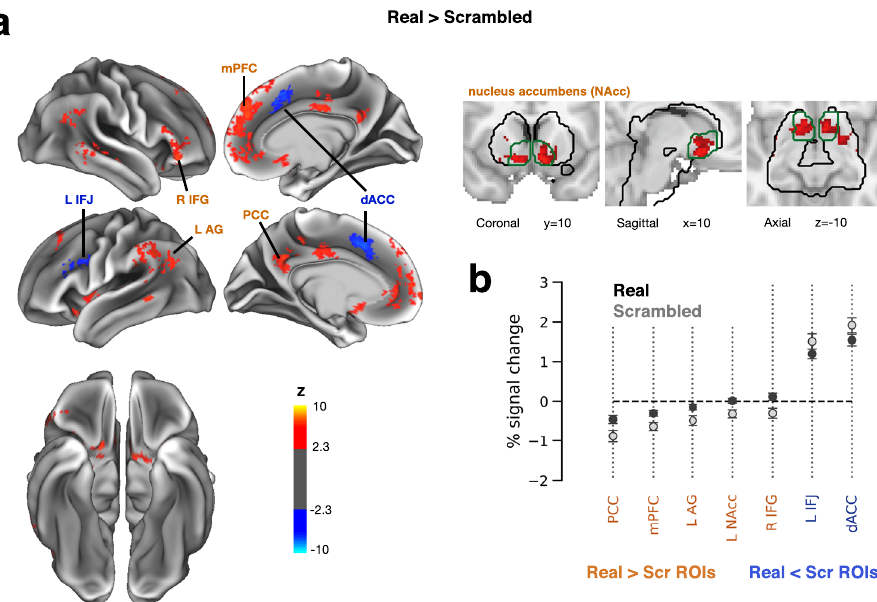
Fig. 6 Comparing the neural responses to phase-scrambled and real object images. a Group-level GLM contrast of real object > scrambled images. Left: data overlaid on a template cortical surface. Right: data presented in subcortical regions only (within black contour; green contour indicates nucleus accumbens), plotted on MNI152 template brain volume. Data were thresholded using cluster-based FWE-correction in FSL, with a voxel-de fi ning Z statistic threshold of p < 0.01 and a cluster size threshold of p < 0.0.5. b GLM-estimated percent signal change of stimulus-triggered responses, averaged across voxels within clusters shown in a . Orange and blue labels denote clusters with positive and negative contrast values, respectively. In all plots, data are averaged across object categories and error bars indicate s.e.m across subjects ( N = 25). AG: angular gyrus, PCC: posterior cingulate cortex, mPFC: medial prefrontal cortex, IFG: inferior frontal gyrus, acc: accumbens, IFJ: inferior frontal junction, dACC: dorsal anterior cingulate cortex, L: left, R: